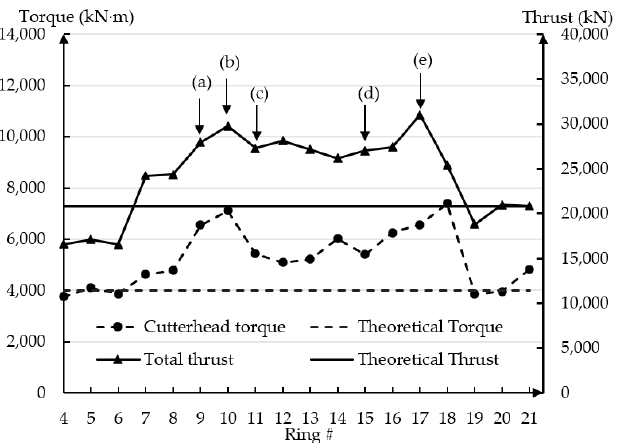
Figure 5. The total thrust force and cutterhead torque variation of the studied tunnel section. Theo- retical torque and thrust are 4012 kNm and 20,783 kN, respectively. Both are calculated from Equa- tions (3) – (7). Arrows indicate mud cake mitigations: (a) modify foam ratio, (b) increase water and dispersant, (c) auxiliary air pressure support, (d) dispersant soaking, and (e) open chamber inspec- tion.